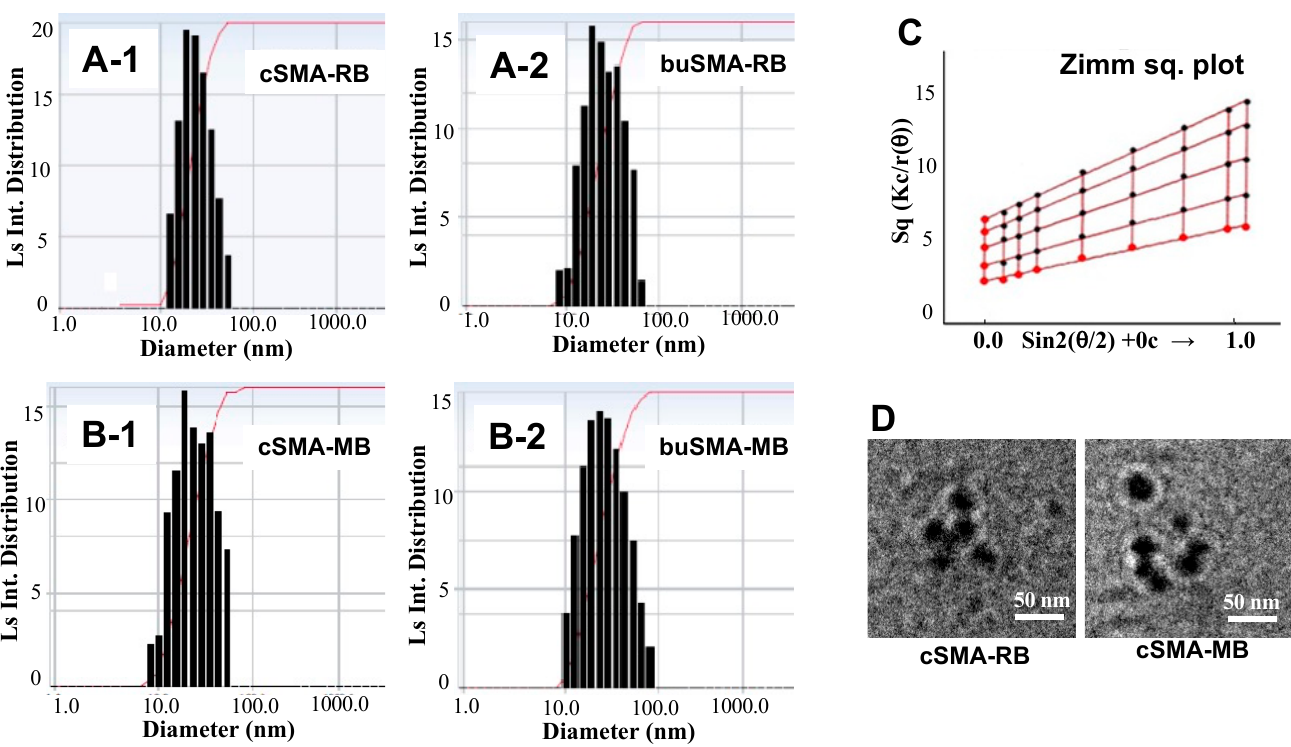
Figure 2. Dynamic light scattering of cSMA-RB ( A-1 ), buSMA-RB ( A-2 ), cSMA-MB ( B-1 ) and buSMA-MB ( B-2 ) micelles. Concentrations of each SMA-PS micelle were 1.25 mg/mL in 0.2 M sodium phosphate buffer (pH 7.4). The Zimm Sq. plot of cSMA-RB micelles by static laser light scattering is shown in ( C ). The particle size and shape were also measured by transmission electron microscopy (TEM) ( D ). Table 2. Particle size (nm) of SMA-PS micelles in different aqueous milieu. SMA Micelles 0.1 M Phosphate Buffer (pH